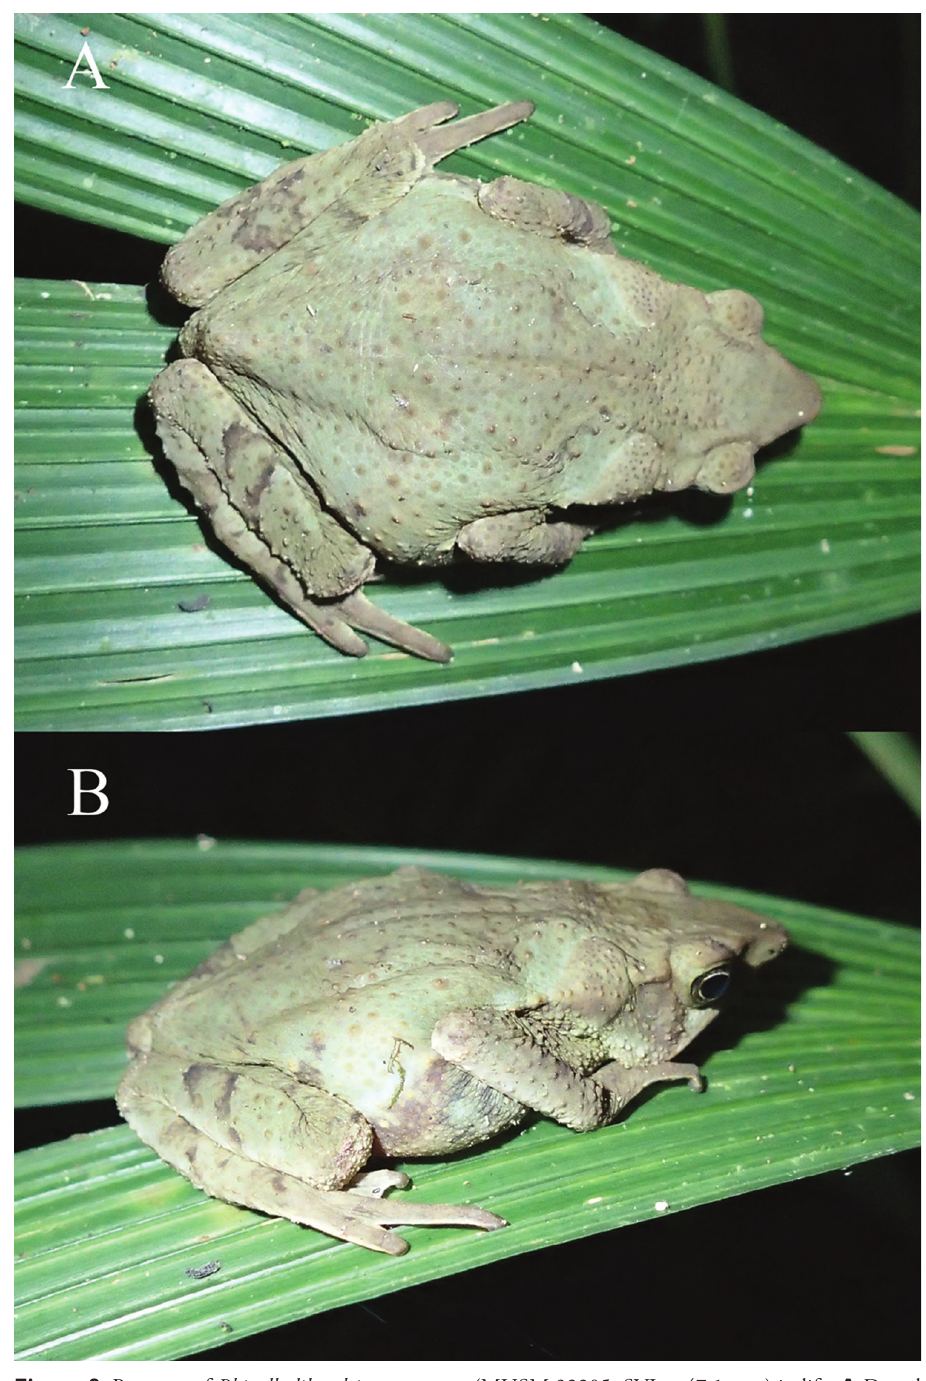
Figure 8. Paratype of Rhinella lilyrodriguezae sp. n. (MUSM 32205, SVL = 47.1 mm) in life. A Dorsal and B laterodorsal views of the coloration during the day. Photos by K.